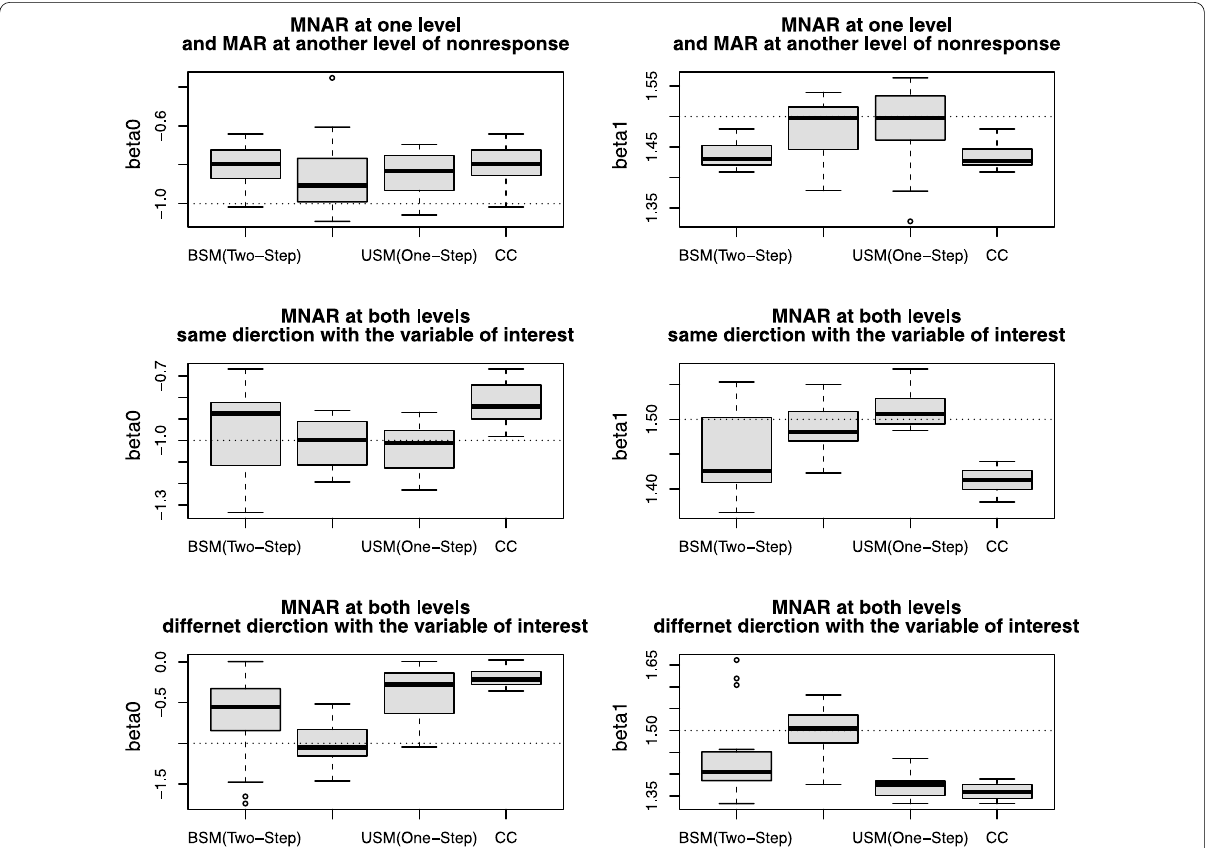
Fig. 1 Boxplots of the estimated regression coefficients of β 0 and β 1 with normality assumption from 500 simulation runs. Methods are the bivariate